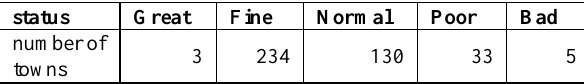
Table 2. Statistical data of eco-environment status